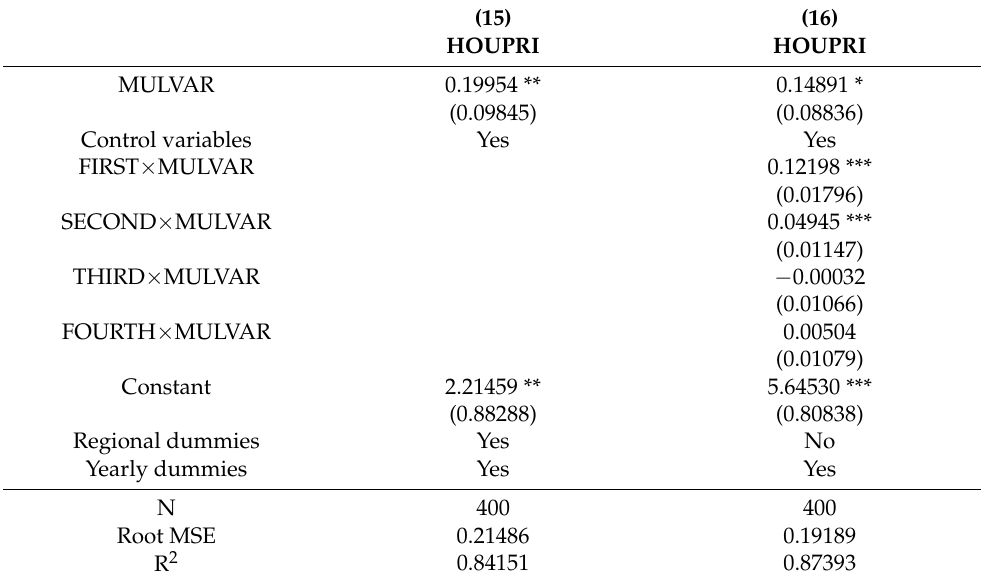
Table 9. Robustness test of the relationship between law-based governance and housing prices.